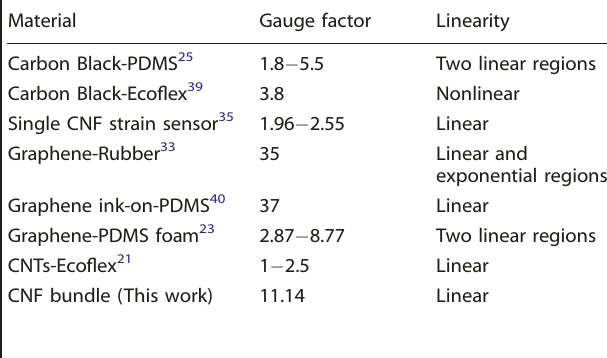
Table 2. Comparing the gauge factors of various fl exible strain sensors reported in the